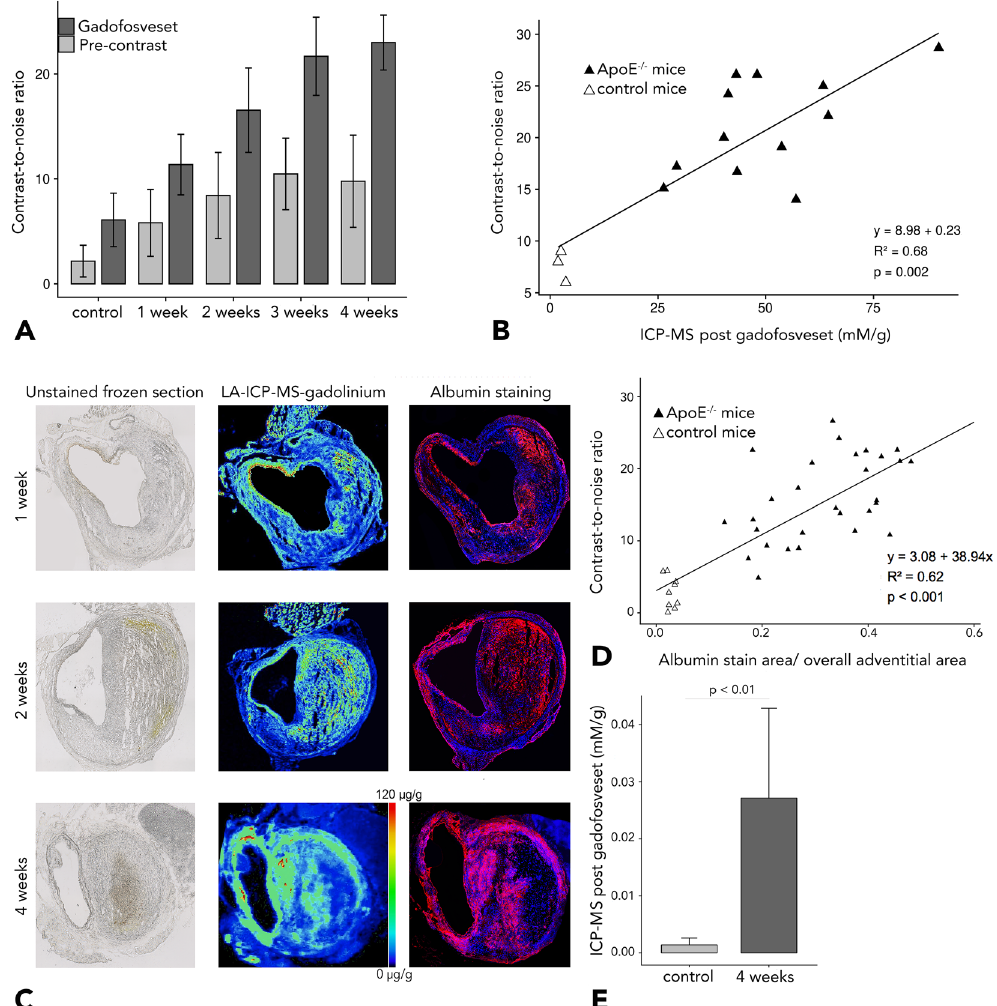
Figure 5. Ex vivo quantification of in vivo MRI results. ( A ) Contrast-to-noise ratios measured in control animals and in ApoE − / − mice after 1, 2, 3 and 4 weeks of Angiotensin II infusion. Postcontrast (gadofosveset) contrast-to-noise ratios show increased signal enhancement with progression of abdominal aortic aneurysm (AAA) in ApoE − / − mice. ( B ) Shows a significant positive correlation between gadofosveset-enhanced contrast- to-noise ratios and gadofosveset-based gadolinium concentrations as determined by inductively coupled plasma mass spectrometry (ICP-MS) (Pearson’s correlation coefficient of R 2 = 0.68). ( C ) Demonstrates the unstained frozen section (left), the spatial distribution of gadolinium (from the albumin-specific gadolinium-based probe) in aortic aneurysms as assessed by LA-ICP-MS (middle) and the co-localization of albumin-positive areas in the fluorescence albumin stain with gadolinium distribution (left). ( D ) Ex vivo relative fluorescence albumin- stained areas also demontrate significant correlation with in vivo measured contrast-to-noise ratios (R 2 = 0.62). ( E ) Compared to sham-treated animals, Angiotensin II-infused ApoE − / − mice at 4 weeks show significantly higher gadolinium content as determined by ICP-MS. n = 9 per group for the MRI experiments. n = 3 per group for